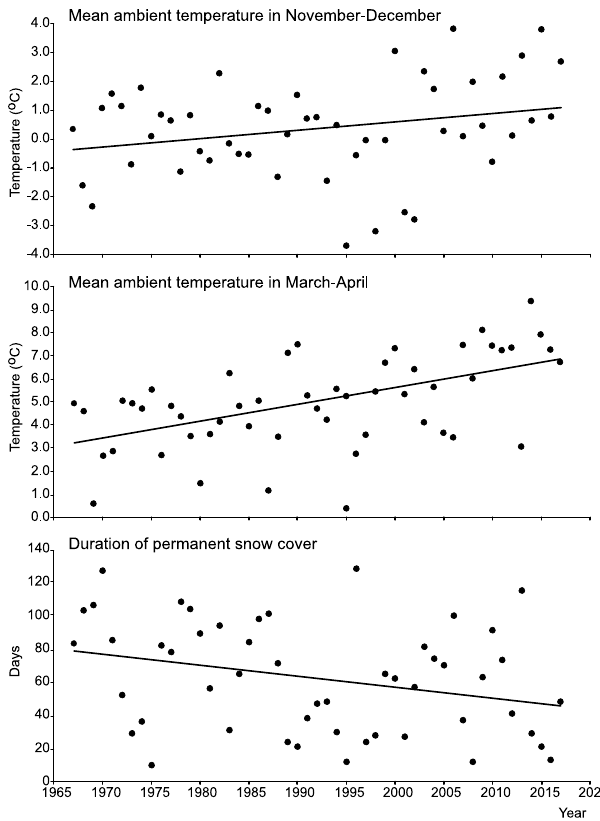
Figure 3. Temporal variation of mean ambient temperatures in November-December (autumn moult of weasels), mean ambient temperatures in March–April (spring moult of weasels) and duration of permanent snow cover during the last 50 years (1967–2017) in the Białowieża